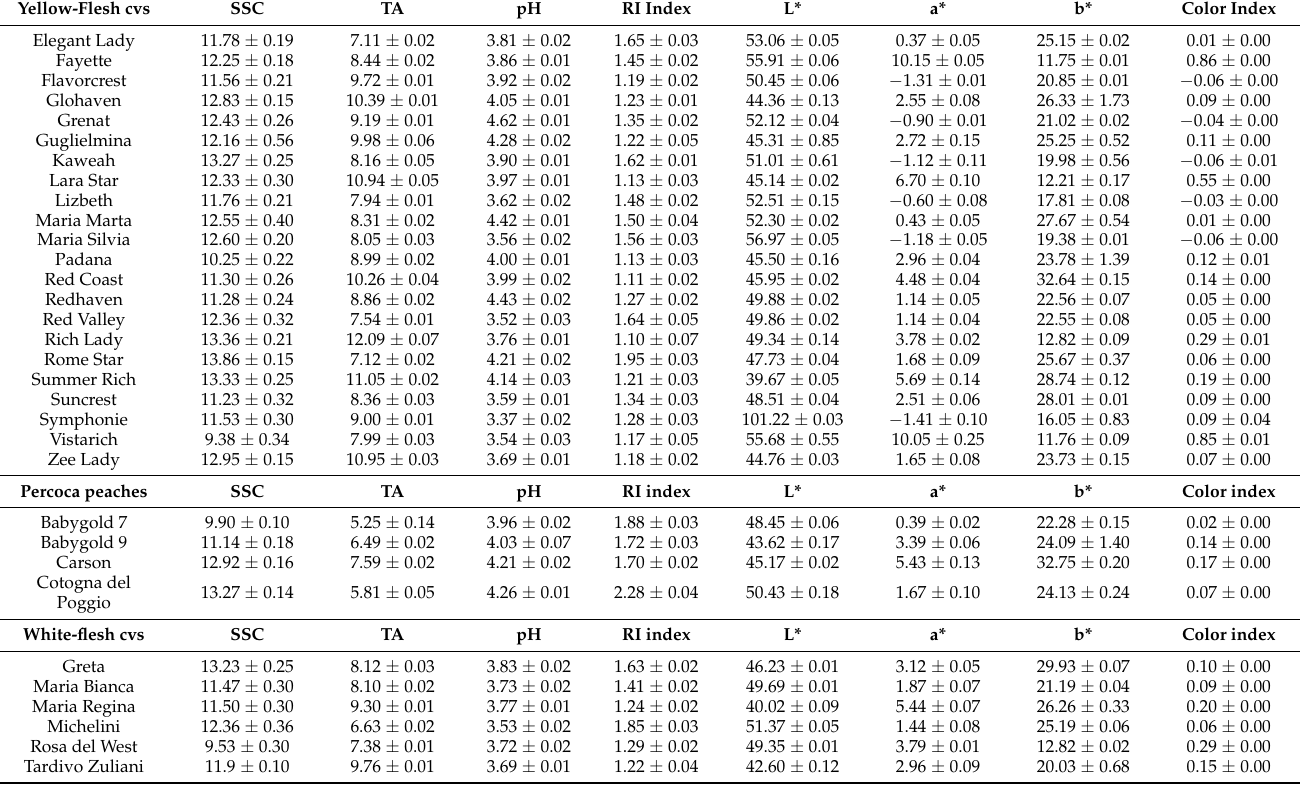
Table 1. Values of Quality Indices SSC (%, total soluble solids content), TA (g malic acid L − 1 , titratable acidity), pH, RI (ripening index), and flesh color (L*, a*, b*) of yellow and white peaches.